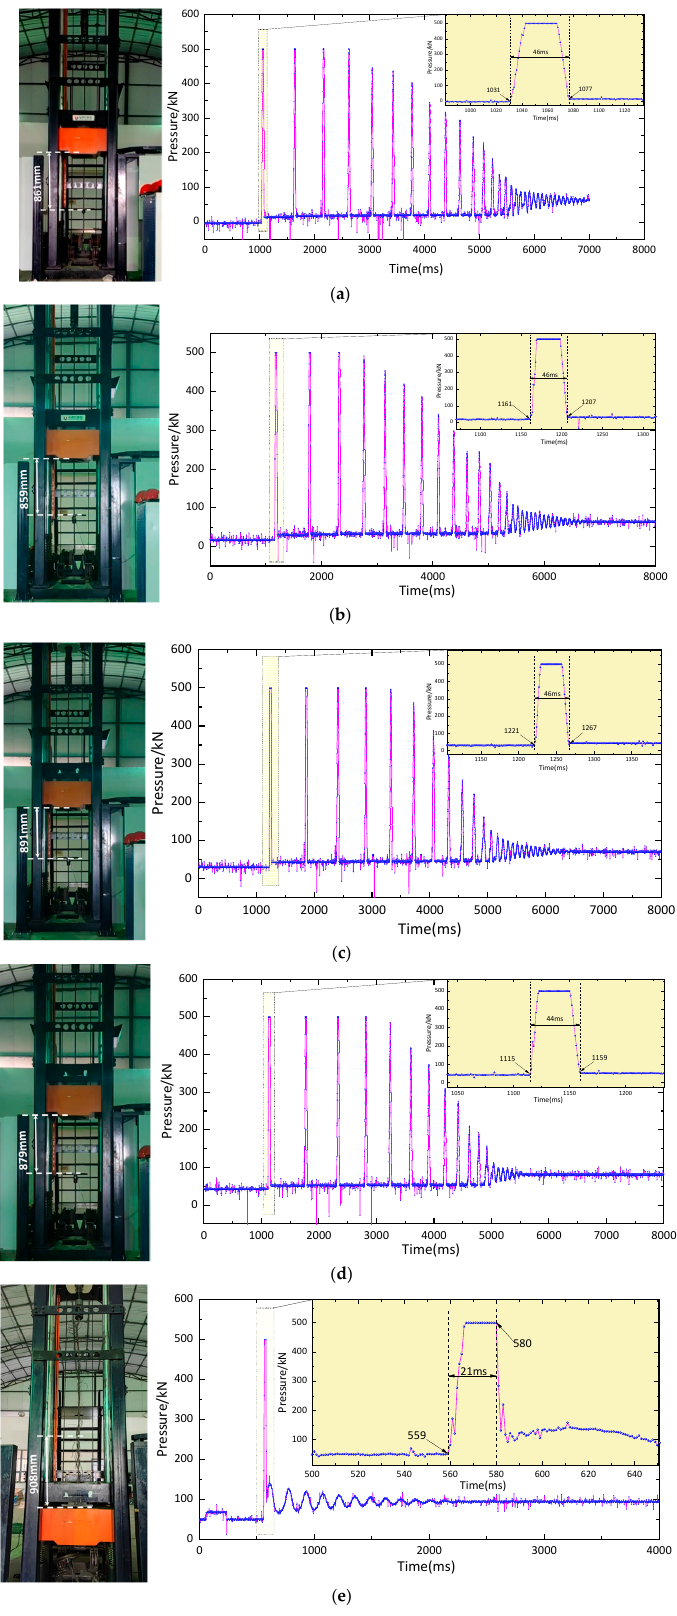
Figure 9. Impact process of Ф 21.8 mm cable: ( a ) Ф 21.8 mm first impact process; ( b ) Ф 21.8 mm second impact process; ( c ) Ф 21.8 mm third impact process; ( d ) Ф 21.8 mm fourth impact process; ( e ) Ф 21.8 mm fifth impact process.